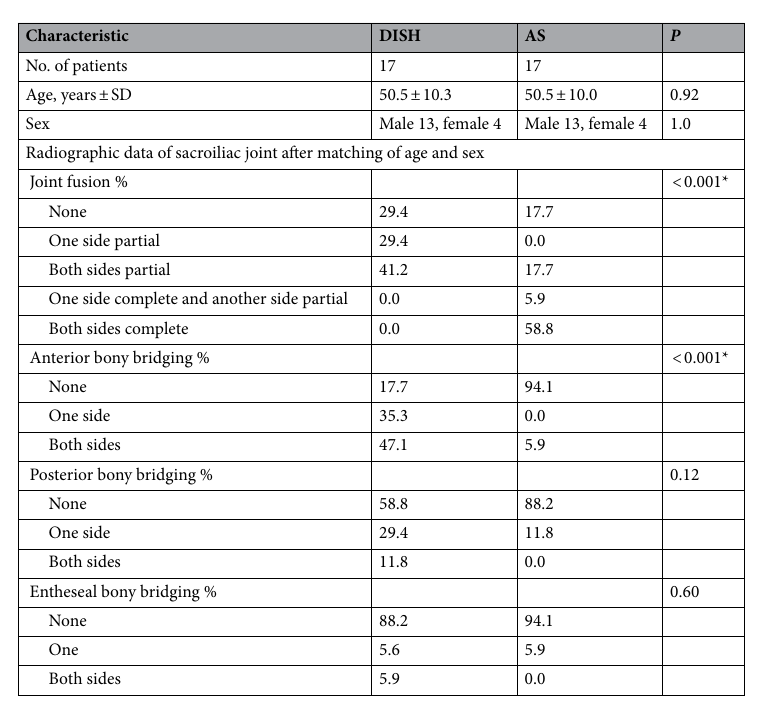
Table 2. Demographic data of patients after matching of age and sex. DISH Diffuse idiopathic skeletal hyperostosis, AS Ankylosing spondylitis, SD standard deviation. * P <